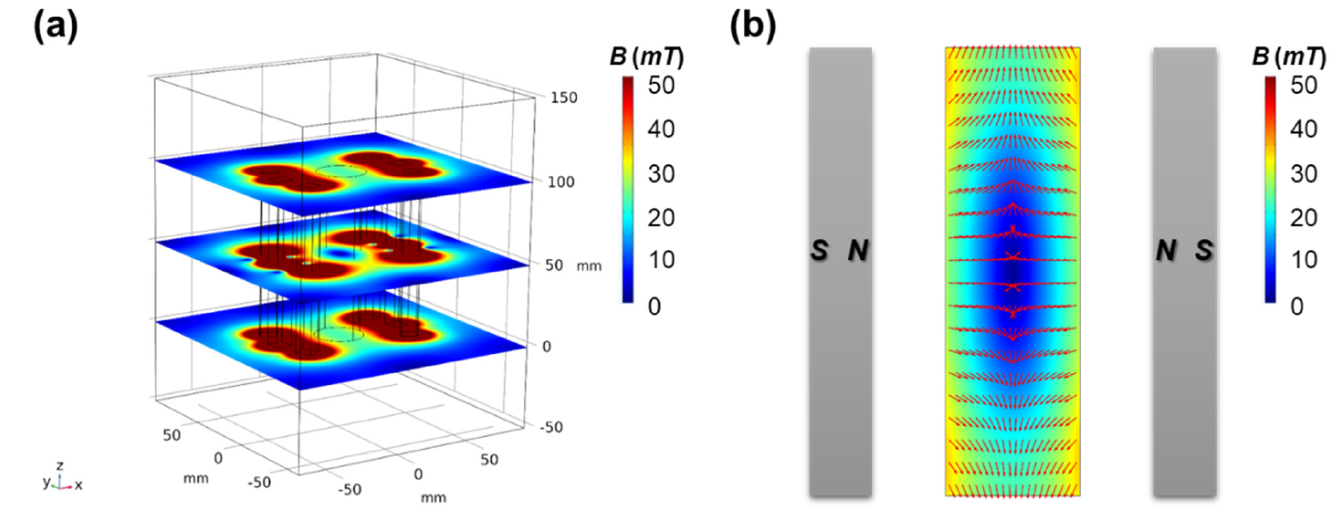
Figure 2. Simulation of the M-MagLev system with six magnets. ( a ) Contour plots of magnetic flux density distribution in horizontal slices of system. ( b ) Contour plots of magnetic flux density distribution in axis section of system. The red arrows indicate the direction of magnetic flux density.